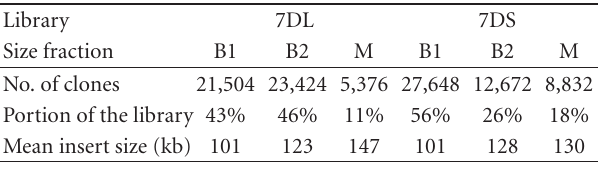
Table 1: Characteristics of individual size fractions of the 7DL- and 7DS-specific BAC libraries.